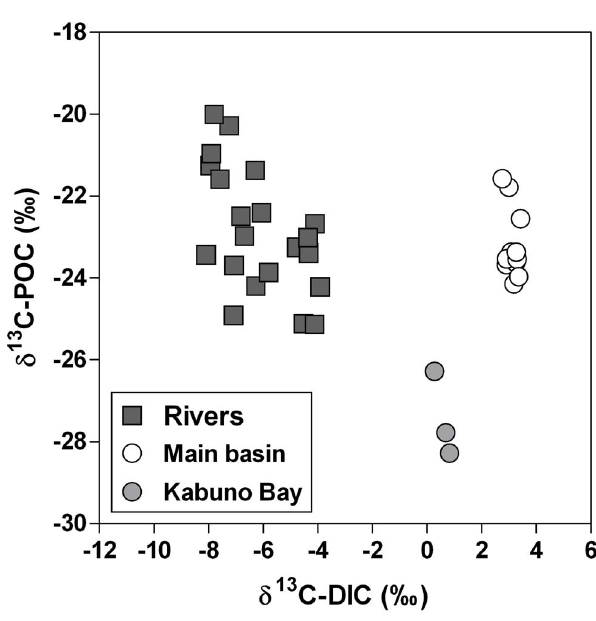
Figure 6. Relation between d 13 C signature of particulate organic carbon (POC) ( d 13 C-POC, % ) and d 13 C signature of dissolved inorganic carbon (DIC) ( d 13 C-DIC, % ), in the mixed layer of the main basin of Lake Kivu, Kabuno Bay and various inflowing rivers, in June 2008, April 2009, and October 2010.